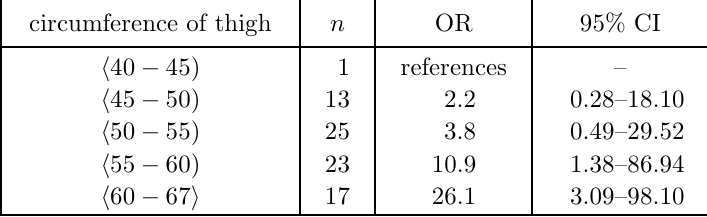
Table 4. Odds ratio for circumference of thigh for girls circumference of thigh